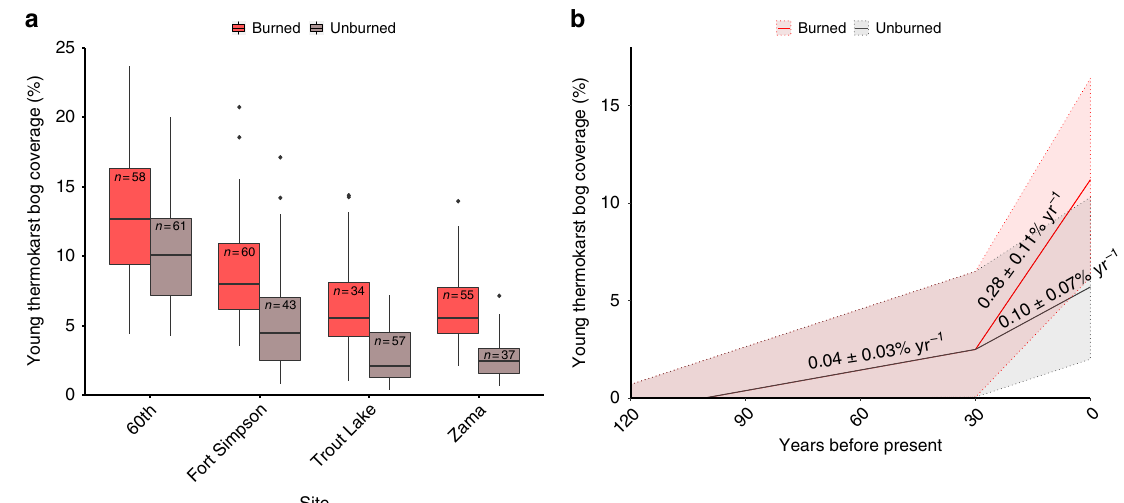
Fig. 5 Effect of wild fi re on permafrost thaw through development of young thermokarst bogs in western Canadian peatlands. a Current-day coverage of young thermokarst bogs in burned and unburned sections within four peatlands partially affected by wild fi re 20 – 30 years ago. Box plots indicate median, interquartile range, and minimum and maximum young thermokarst bog coverage among classi fi ed 250 × 250 m sections, with number of classi fi ed sections indicated ( n ). A pairwise t -test showed a signi fi cant ( p < 0.01) effect of fi re on young thermokarst bog coverage. Sites are ordered left to right by likely decreasing mean annual air temperature, see text for justi fi cation. b Estimated historical development currently present young thermokarst bogs within peatlands in the study region. Young thermokarst bogs persist for 60 – 140 years before succession into mature thermokarst bogs 17 , suggesting that a signi fi cant proportion of young thermokarst bogs currently present developed prior to the more recent fi res. Thermokarst bog development rates are stated with 95% CI (Methods), which are also indicated by